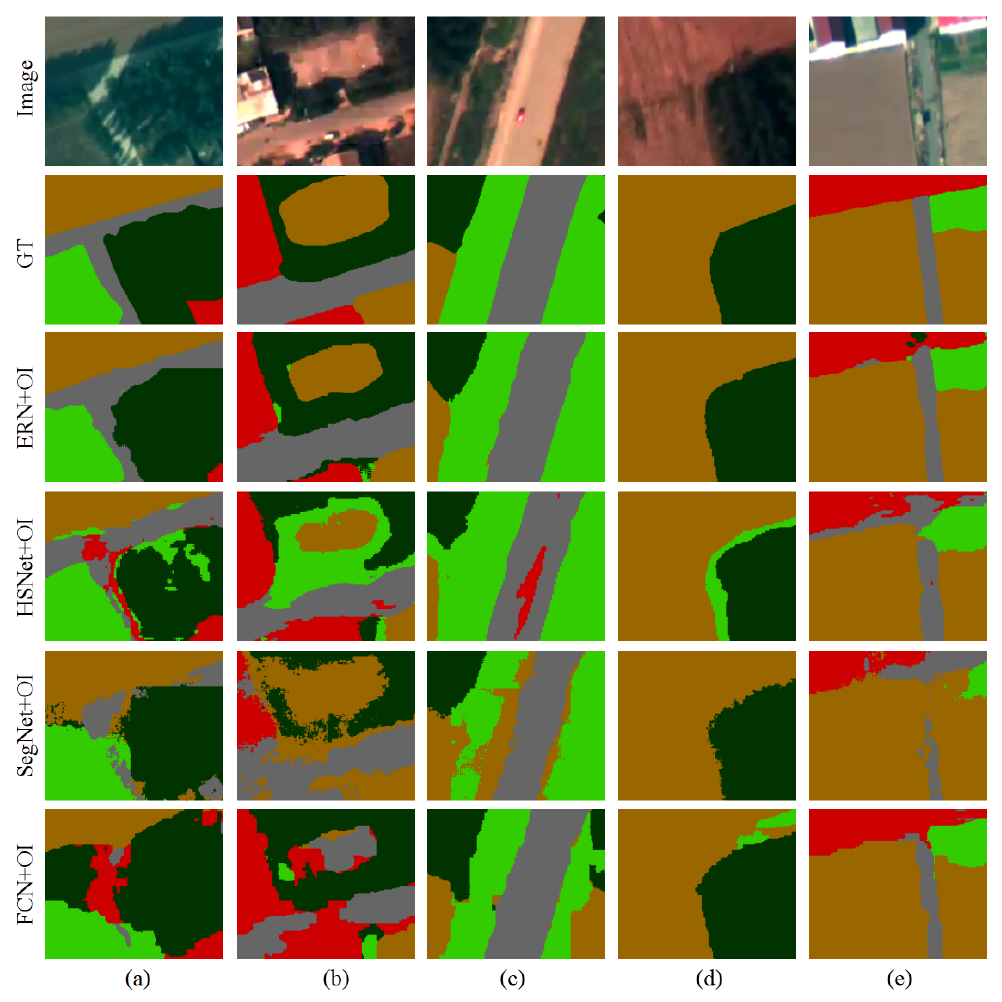
Figure 7. Semantic segmentation results for some local details of the UAV images. ( a ) shadow-affected region; ( b ) similar appearance between road and land; ( c – e ) challenge cases near the boundary; red: buildings; gray: roads; bright green: grass; dark green: trees; brown: land; purple: